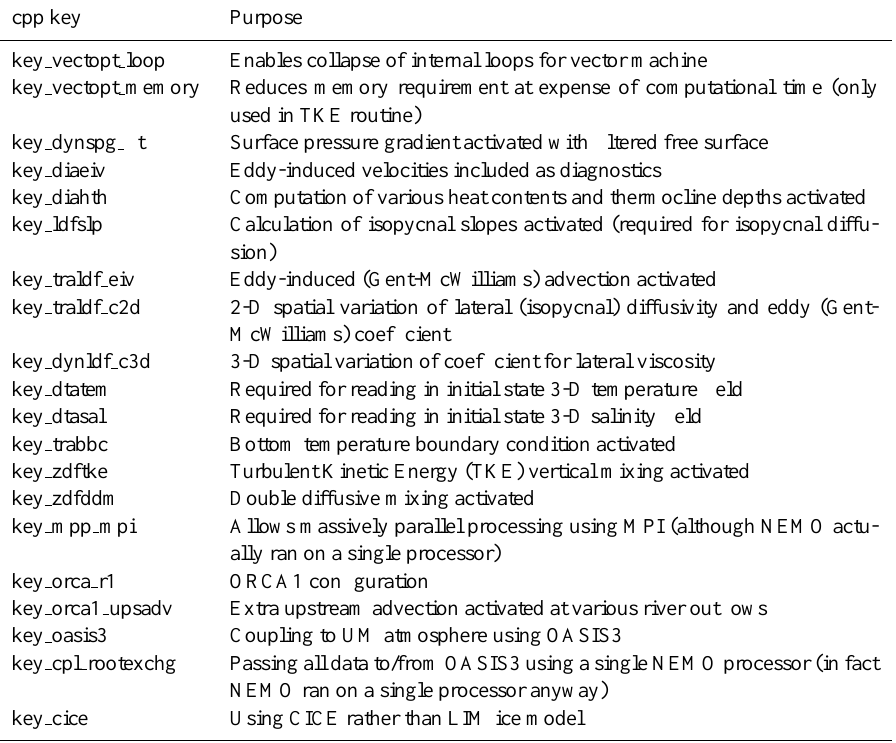
Table B1. The C preprocessor keys used for NEMO in